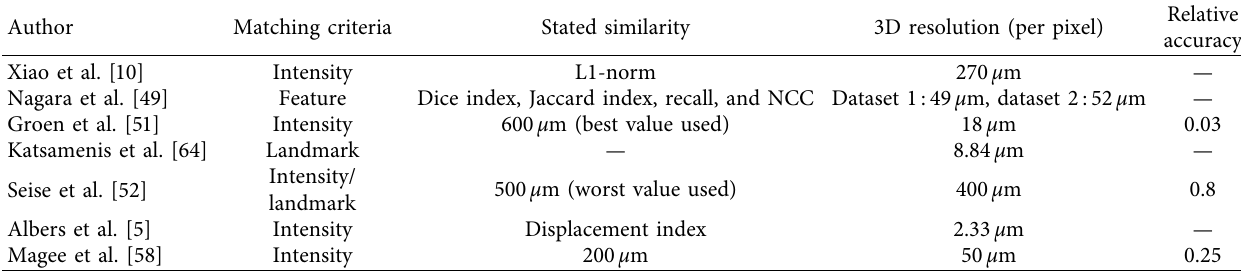
Table 2: Quantitative comparison of the stated similarities and resolution for the image-to-image strategies taken from the literature discussed.